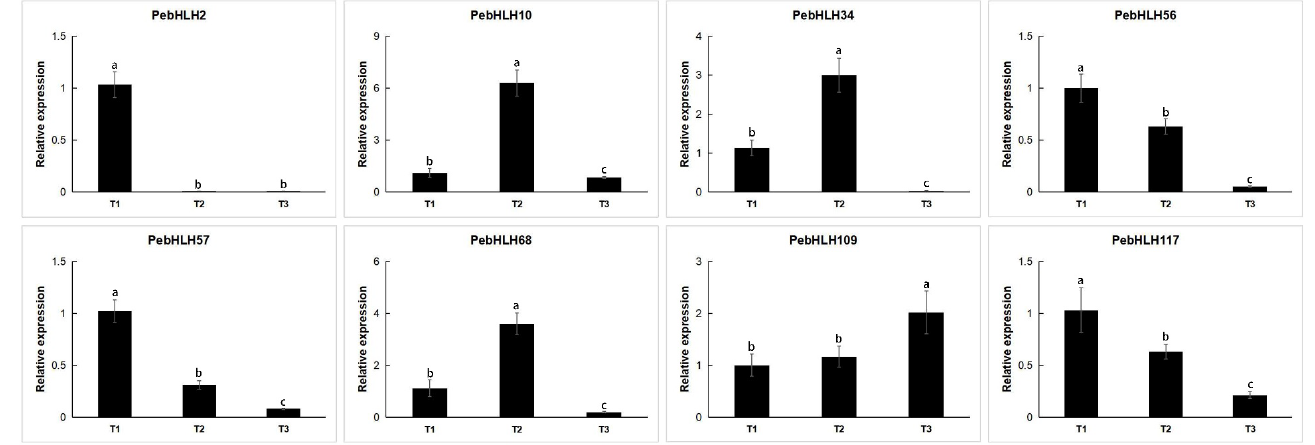
Figure 10. qRT-PCR analysis of 8 PebHLHs during 3 fruit ripening periods (Table S5). Horizontal coordinates indicate different stress treatments, and vertical coordinates represent relative expression values. Biological replicates, tests, and p values are described above. The different letters mean significance, which was examined by Duncan’s range test ( p < 0.05).